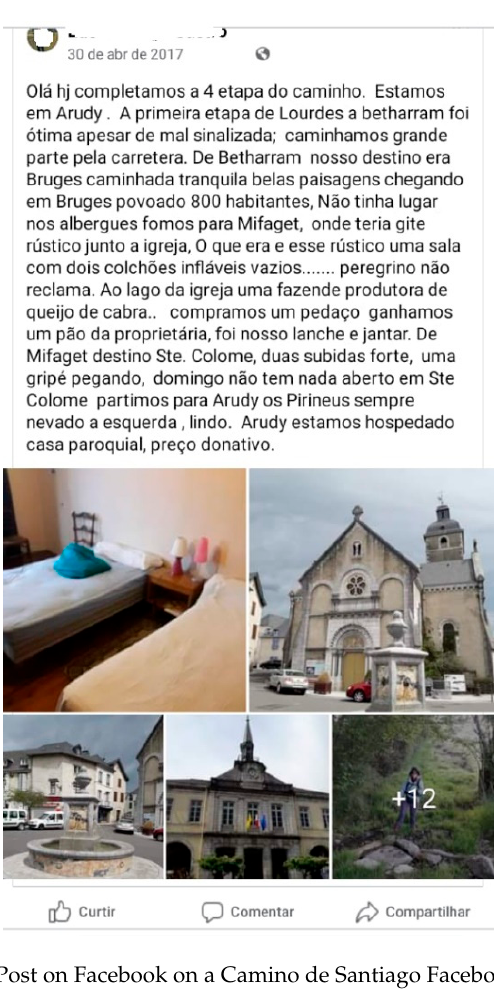
Figure 2. Post on Facebook on a Camino de Santiago Facebook group .